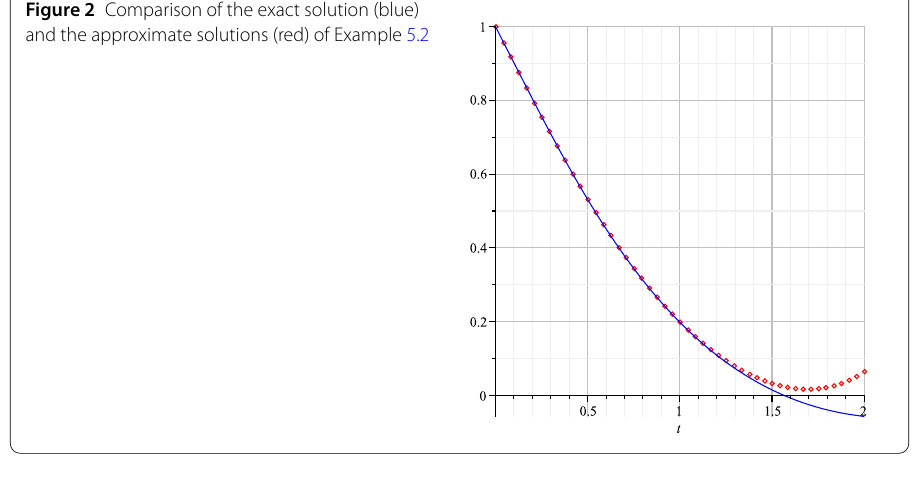
Figure 3 Comparison of the exact solution (blue) and the approximate solutions (red) of Example